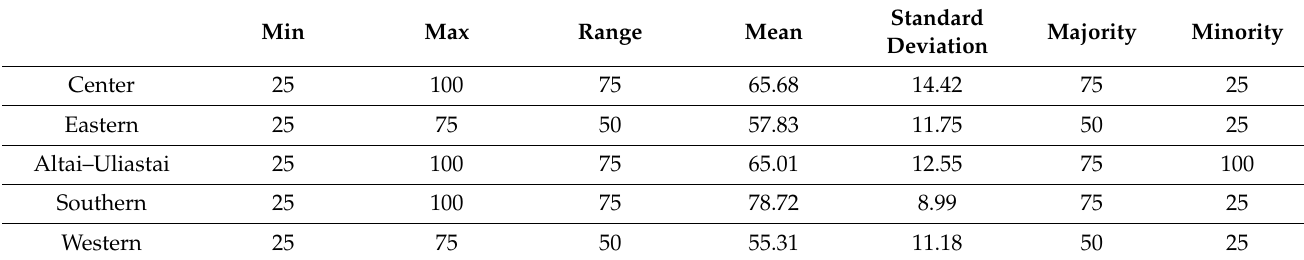
Table 5. Statistical analysis of each Mongolian administrative area’s suitability score.